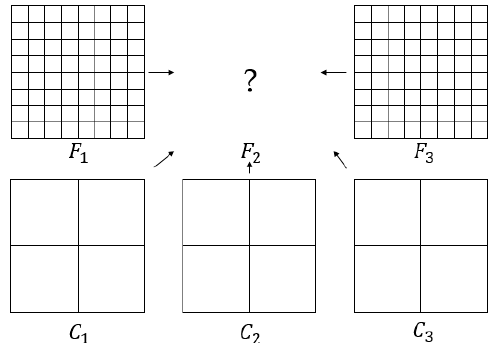
Figure 1. Schema of the enhanced linear regression spatio–temporal fusion method (ELRFM). F 1 / C 1 , F 2 / C 2 , and F 3 / C 3 indicate fine / coarse resolution images at t 1 , t 2 , and t 3 ,